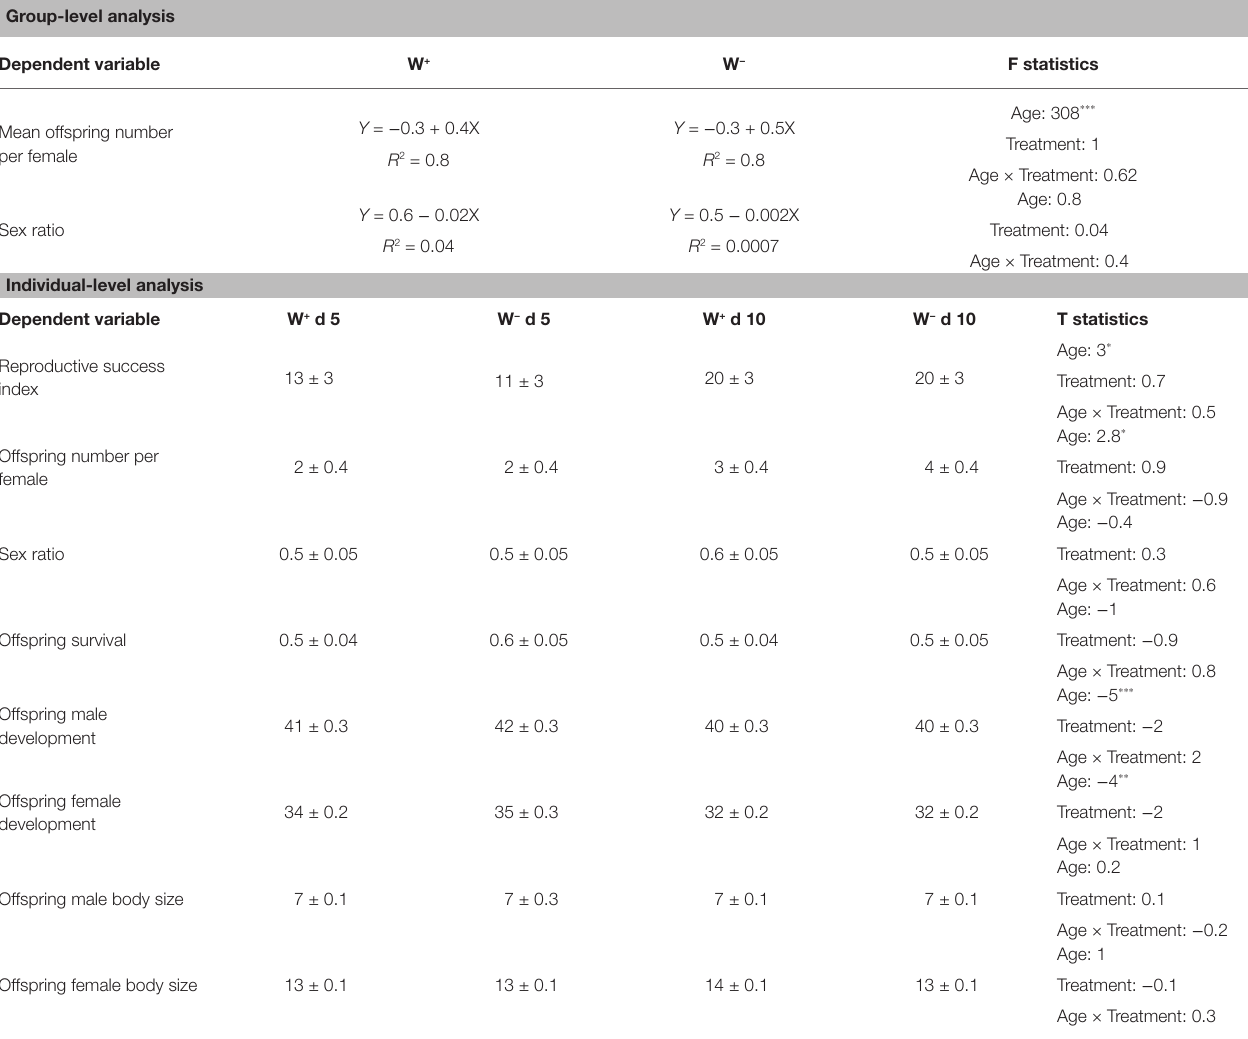
TABLE 1 | Experimental results. Group-level